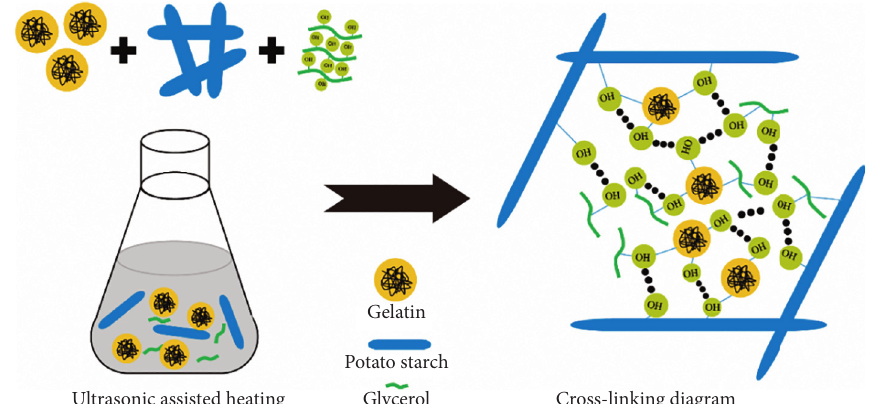
Figure 5: FTIR spectra of optimized films.